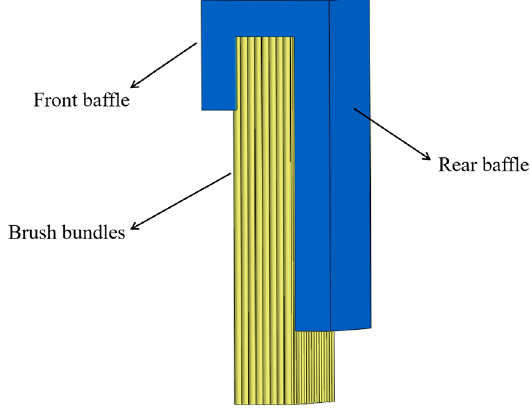
Figure 1. Schematic diagram of the basic structure of a brush seal.